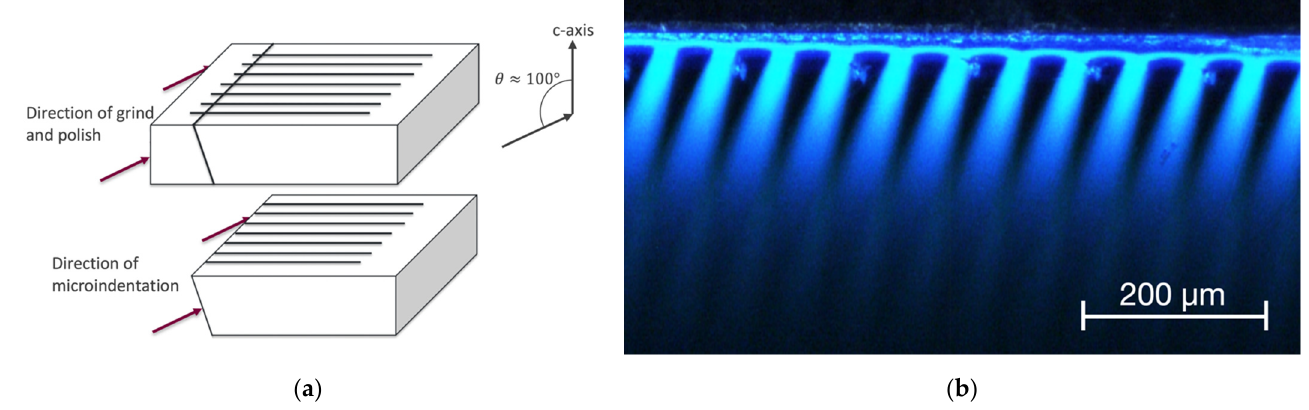
Figure 4. ( a ) A simplified diagram of the die structure to show grinding direction, viewing angle and microindentation direction of Sample 2. ( b ) Optical microscopy image of Sample 2 after second-stage microindentation.